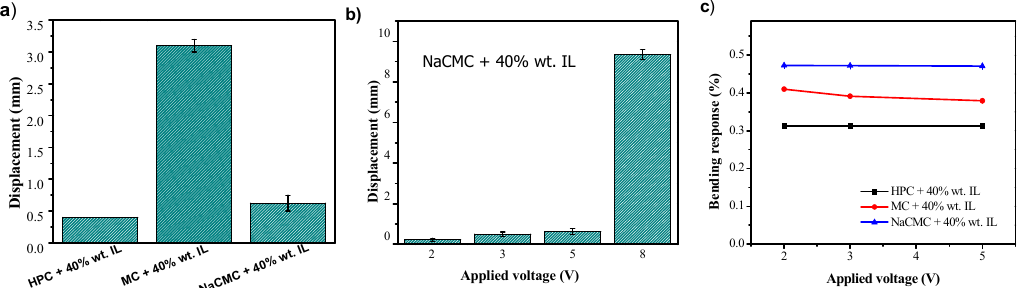
Figure 7. Displacement of the composites for ( a ) an applied voltage of 5 V at a frequency of 100 mHz for HPC, MC, and NaCMC composites containing 40% wt. of IL and ( b ) as a function of the applied voltage for the NaCMC + 40% wt. IL composite at 100 mHz. ( c ) Bending response as a function of the applied voltage for the different cellulose derived composites.